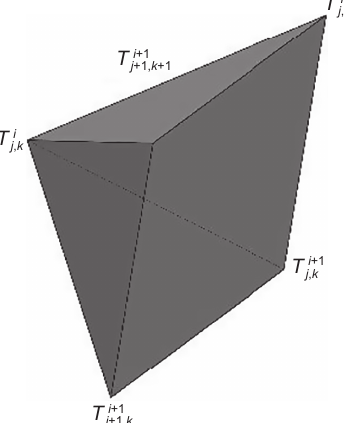
Figure 1. The first and second step of the proposed